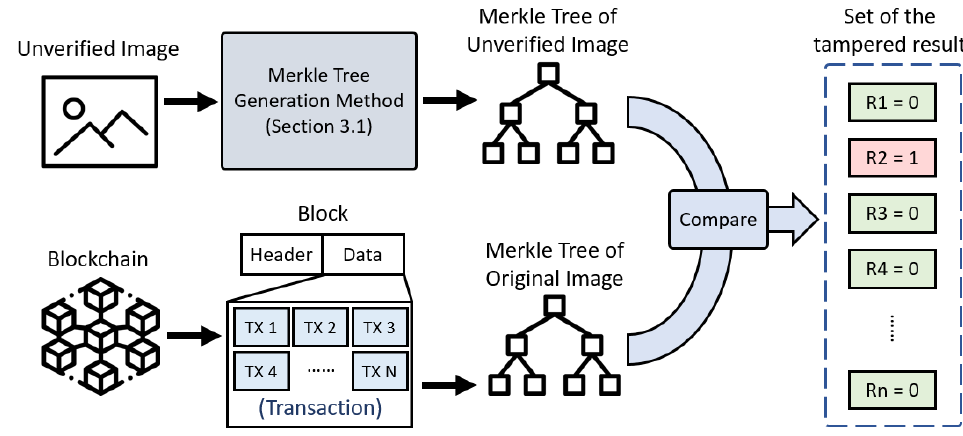
Figure 9. Process of image verification.